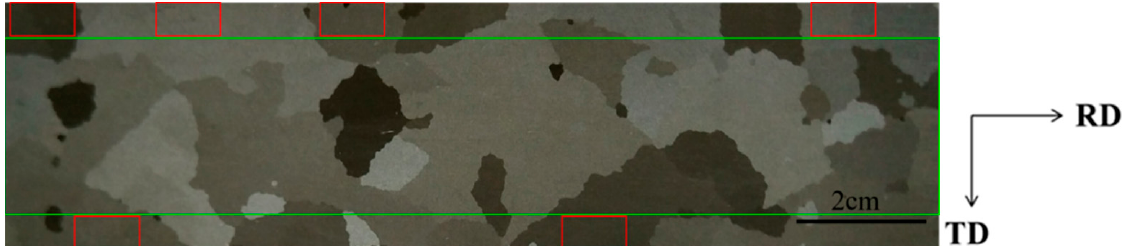
Figure 1. Schematic diagram of sample cutting.